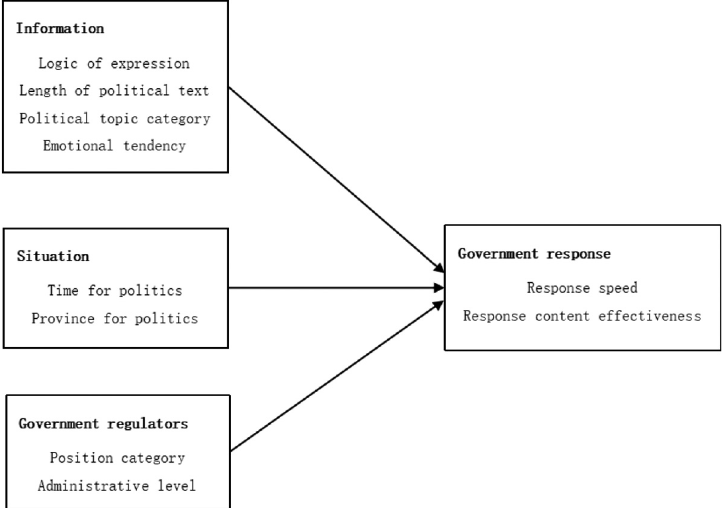
Figure 1. In fl uencing factors model of government response